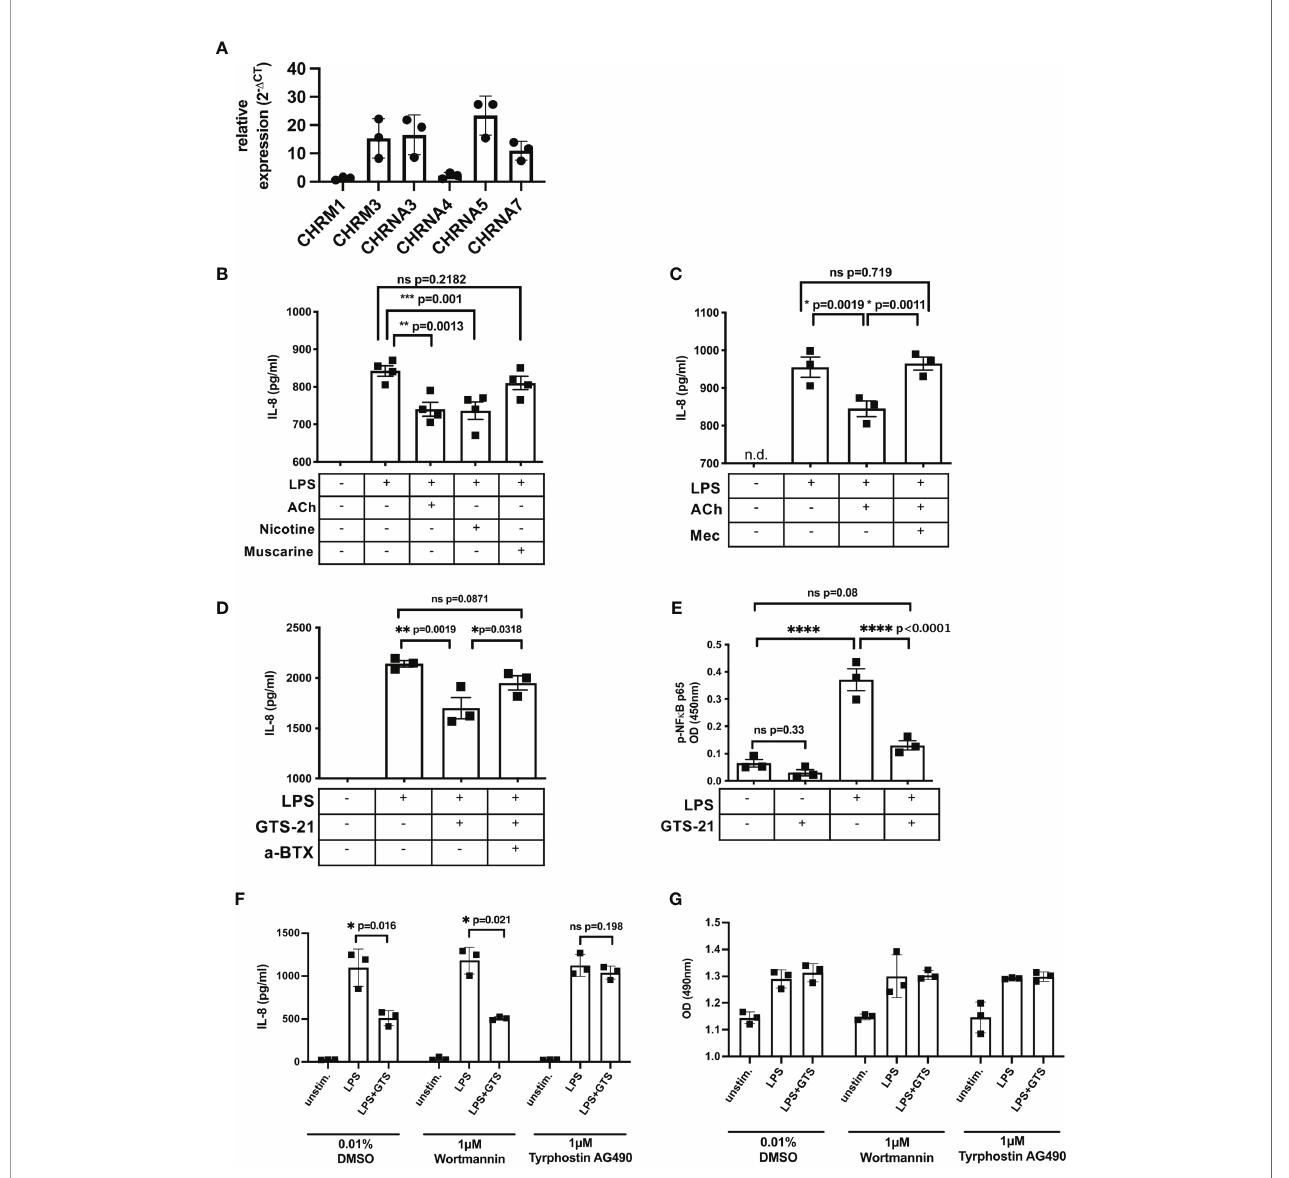
FIGURE 5 | Cholinergic stimulation attenuates LPS-induced IL-8 response in SW480 cells via a7nAChR. Expression of ACHRs in SW480 cells (A) . SW480 cells (5 x 10 4 /200µl) were stimulated with LPS (100ng/ml) in the presence of different agonist and antagonists. IL-8 was measured in cell-free supernatants 20h after LPS stimulation. Cells were stimulated with LPS 20min prior to acetylcholine (ACh, 10µM), nicotine (10µM), and muscarine (10µM) stimulation (B) . Cells were pretreated (20min) with the non-selective nAChR antagonist Mecamylamine (Mec, 100µM) followed by treatment with ACh (10µM), 20min prior to LPS stimulation (C) . Cells were pretreated (20min) with the selective a7nAChR antagonist alpha-Bungarotoxin (a-BTX, 100µM) followed by treatment with GTS-21 (100µM), 20min prior to LPS stimulation (D) . Cells were pretreated (20min) with GTS-21 (100µM) followed by stimulation with LPS. Phospho (p)-NF ĸ B-p65 was measured 4h after LPS stimulation (E) . Cells were pretreated (20min) with DMSO (0.01%, control) or tyrphostin AG490 (1µM) or wortmannin (1µM) followed by stimulation with LPS (100ng/ml), 20min prior to treatment with a7nAChR agonist GTS-21 (20min) (F) . Cell viability was assessed by colorimetric MTS assay (G) . Each point in the scatter plots with bar represent triplicates or quadruplicates ± SEM. Data are representative of three independent experiments. Signi fi cance was determined using one-way ANOVA multiple comparison analysis (A – D) and paired t test (E, F) with *p ≤ 0.05; **p ≤ 0.01; ***p ≤ 0.005. ns, not signi fi cant. n.d., not